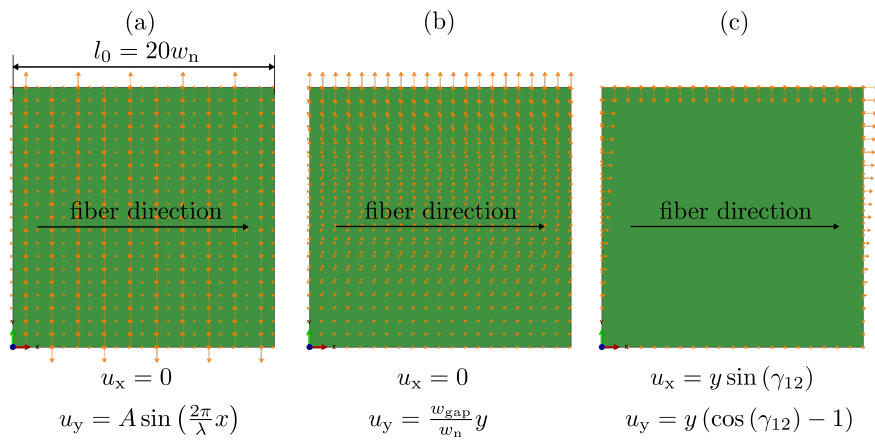
Figure 7. Load case definition for wavy pattern ( a ); gapping ( b ); and shearing ( c